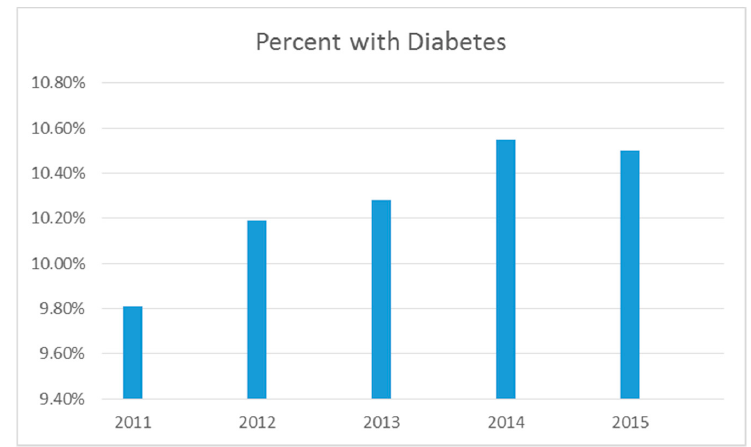
Figure 1. Percentage of adults with diagnosed diabetes, 2011–2015.